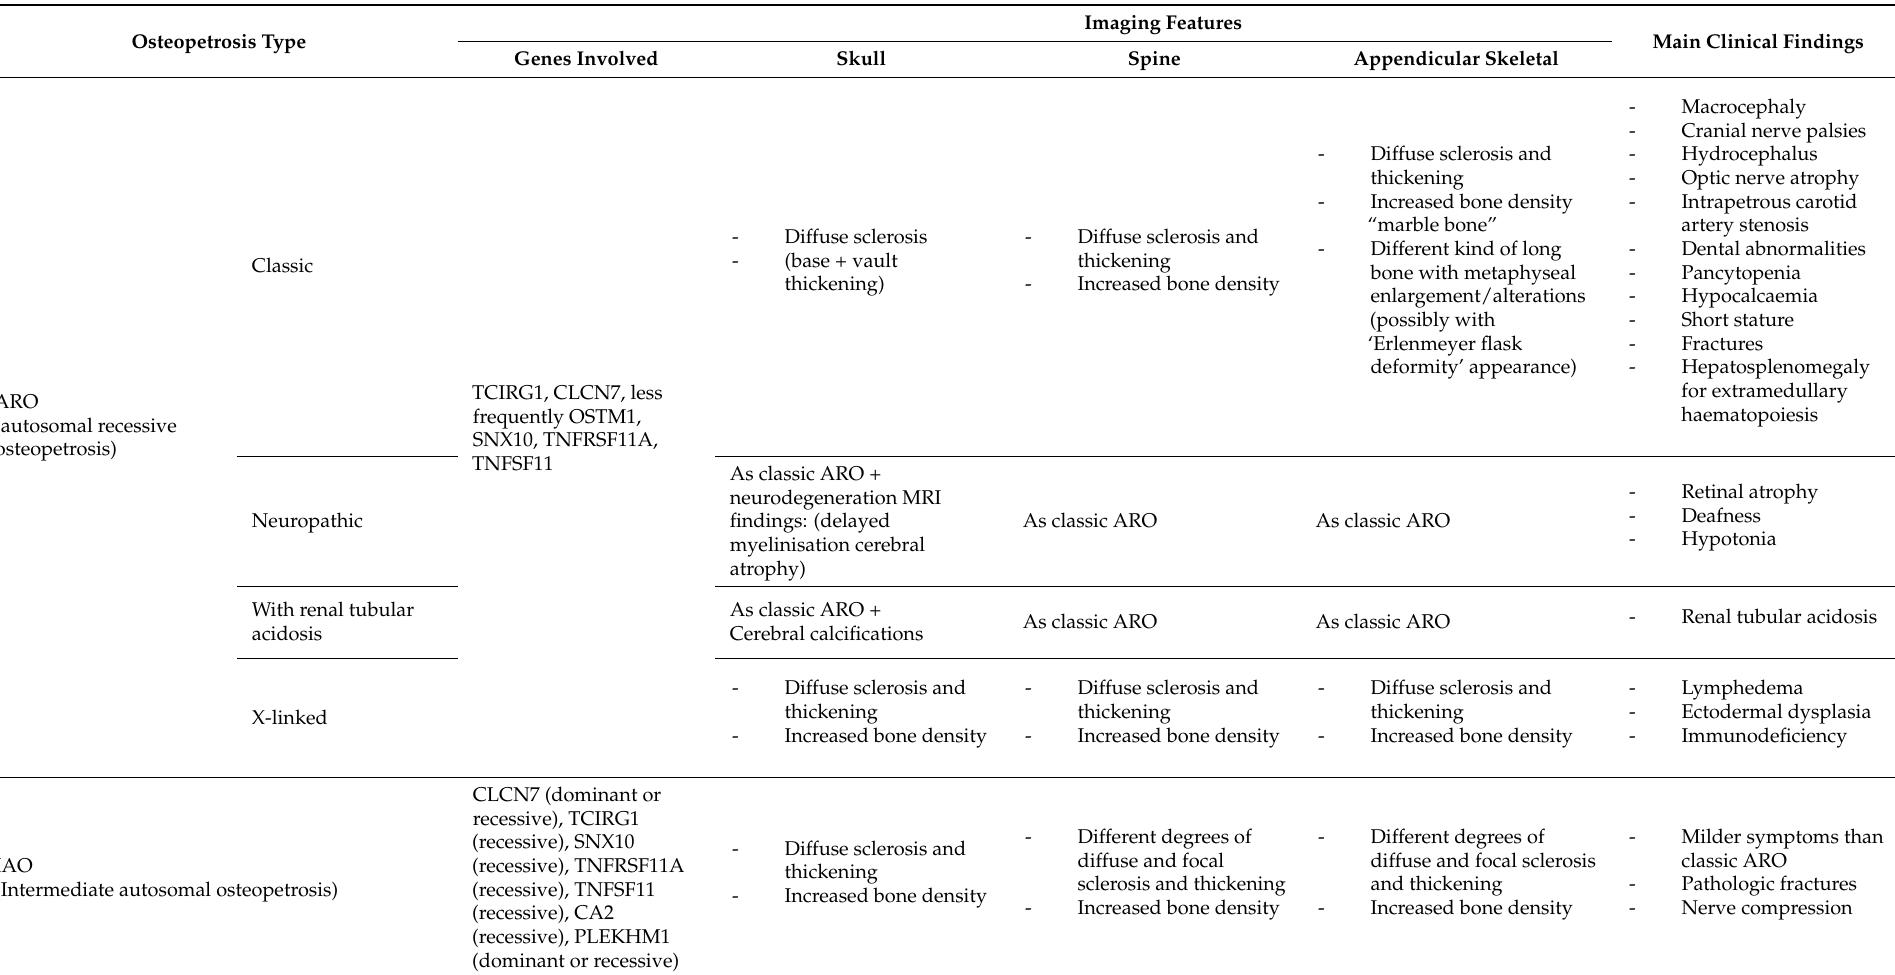
Table 1. Different types of osteopetrosis, the known genes involved, and their main radiological features together with the associated clinical